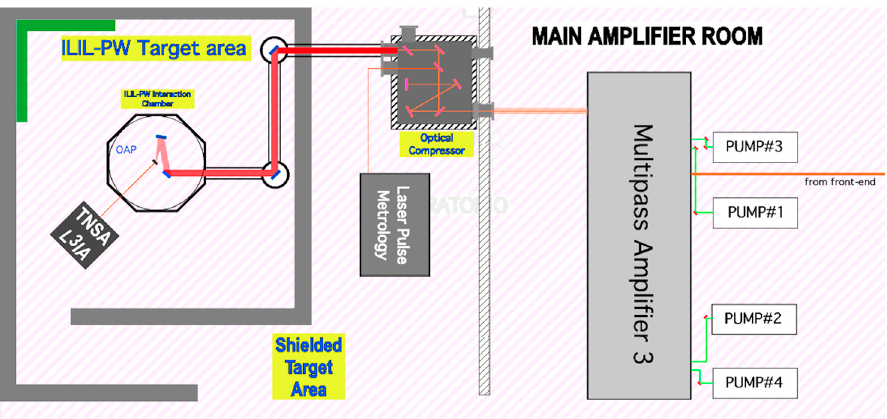
Figure 1. Schematic view of the ILIL-PW facility at INO, including the main amplifier room, the shielded target area, and the laser-driven light ions acceleration (L3IA) dedicated line. OAP: Off-Axis Parabolic.